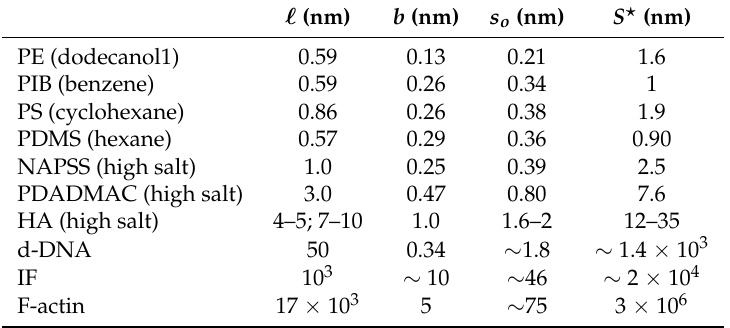
Table 2. Characteristic length scales for chemisorption of a single worm-like chain. The typical zipping loop size is s 0 . For long chains S > S (cid:63) , zipping occurs from multiple nucleation points distant along the